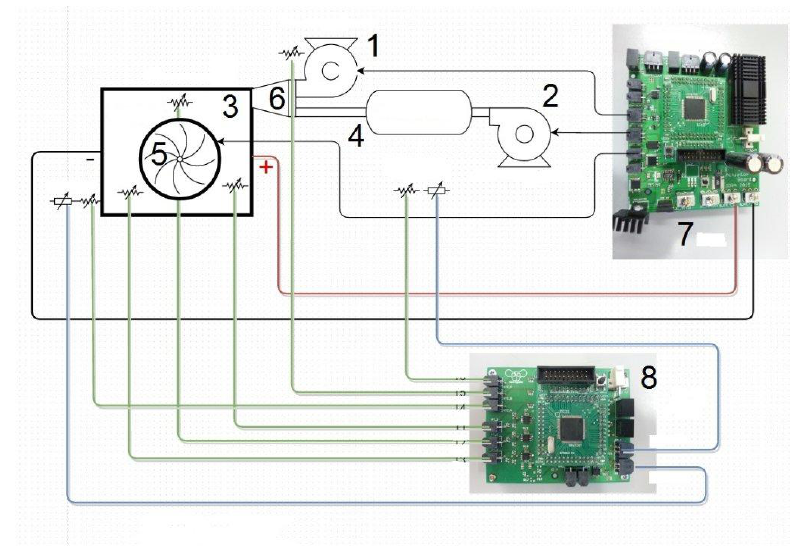
Figure 7. Electronic scheme of the NTHS with sensors and